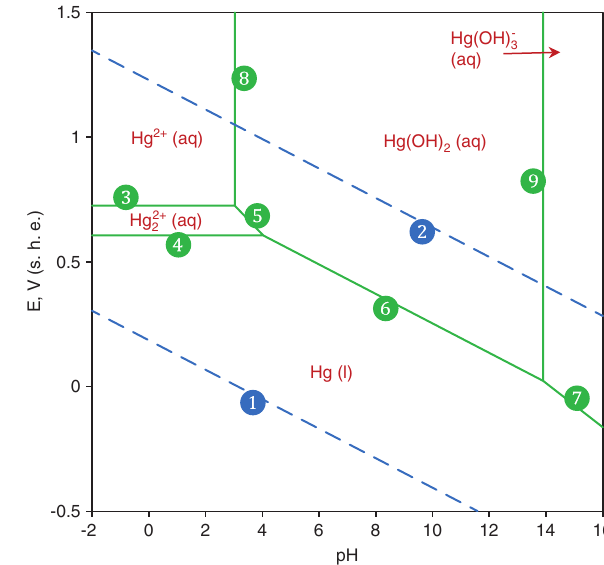
OHg -H + system at 310.75 K 22